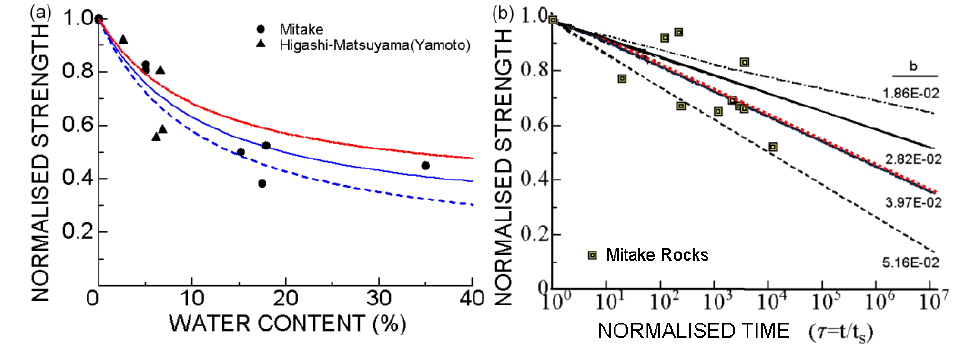
Figure 1. Degradation of strength of rocks of abandoned mines in Mitake with water content and long-term creep loading ( b is empirical coefficient in the empirical long-term strength relation). (a) Effect of water content. (b) Long-term strength.